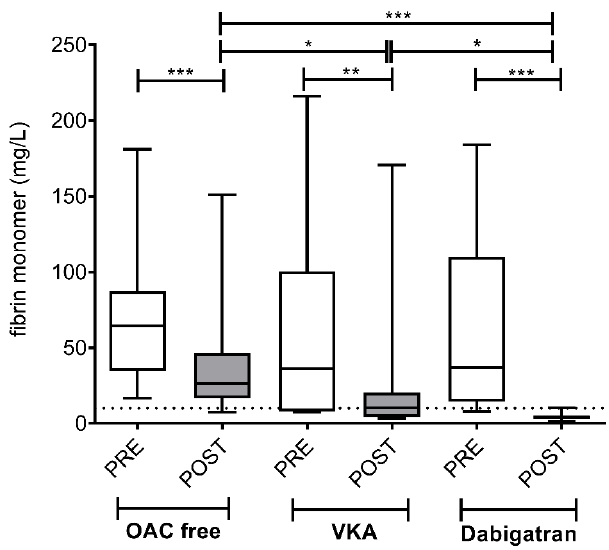
Figure 6. Left atrium fibrin monomer levels before and after cryoballoon ablation procedure in AF patients on various pre-procedural anticoagulation strategies. Box and whisker plots indicate median, interquartile range, and total range. Dashed lines indicate diagnostic cut-off level for prethrombotic conditions (10 mg/L). PRE (empty bars): pre-ablation, POST (solid bars): post-ablation, OAC: oral anticoagulant, VKA: vitamin K antagonist. * p < 0.05, ** p < 0.01, *** p < 0.001. Statistical significance remained essentially the same when assessed after controlling for the effect of covariates associated with selection (age, sex) between treatment groups.